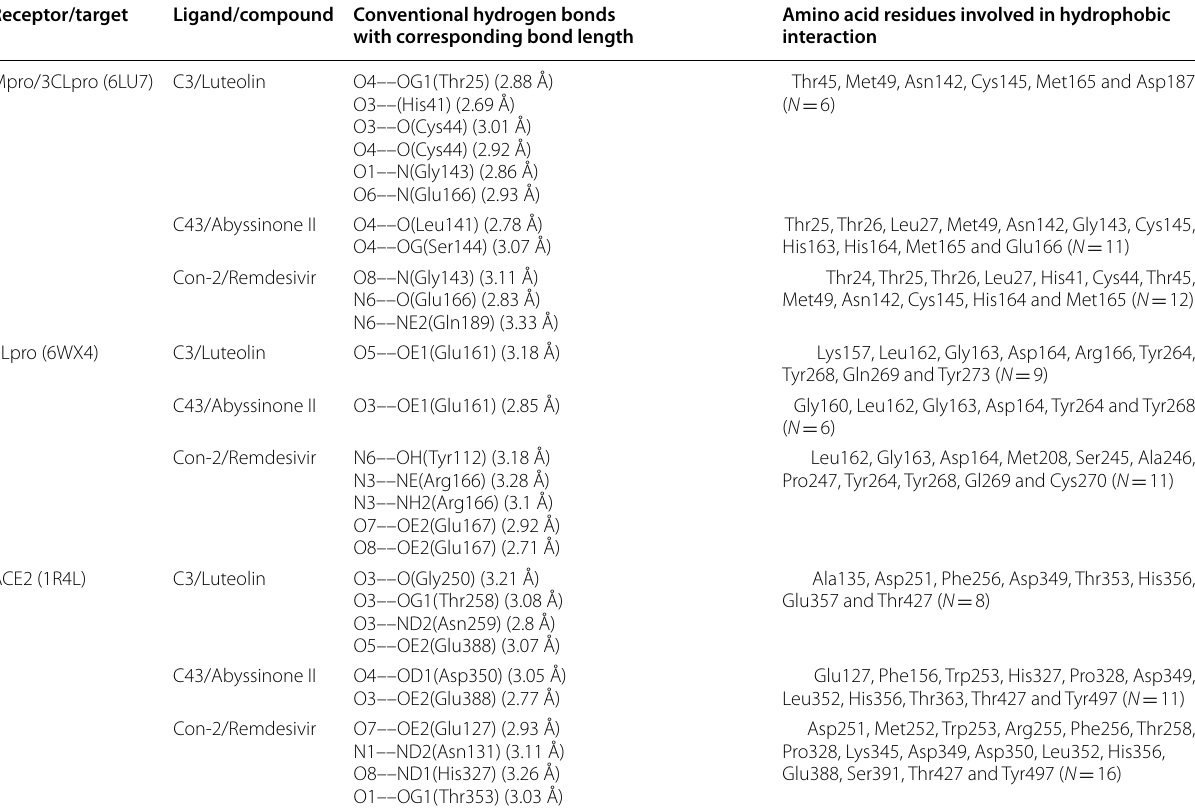
Table 5 Interaction pattern analysis of two top ranked flavonoids (C3/luteolin and C43/abyssinone II) along with top control drug (Con-2/remdesivir) against Mpro/3CLpro, PLpro and ACE2 of COVID-19